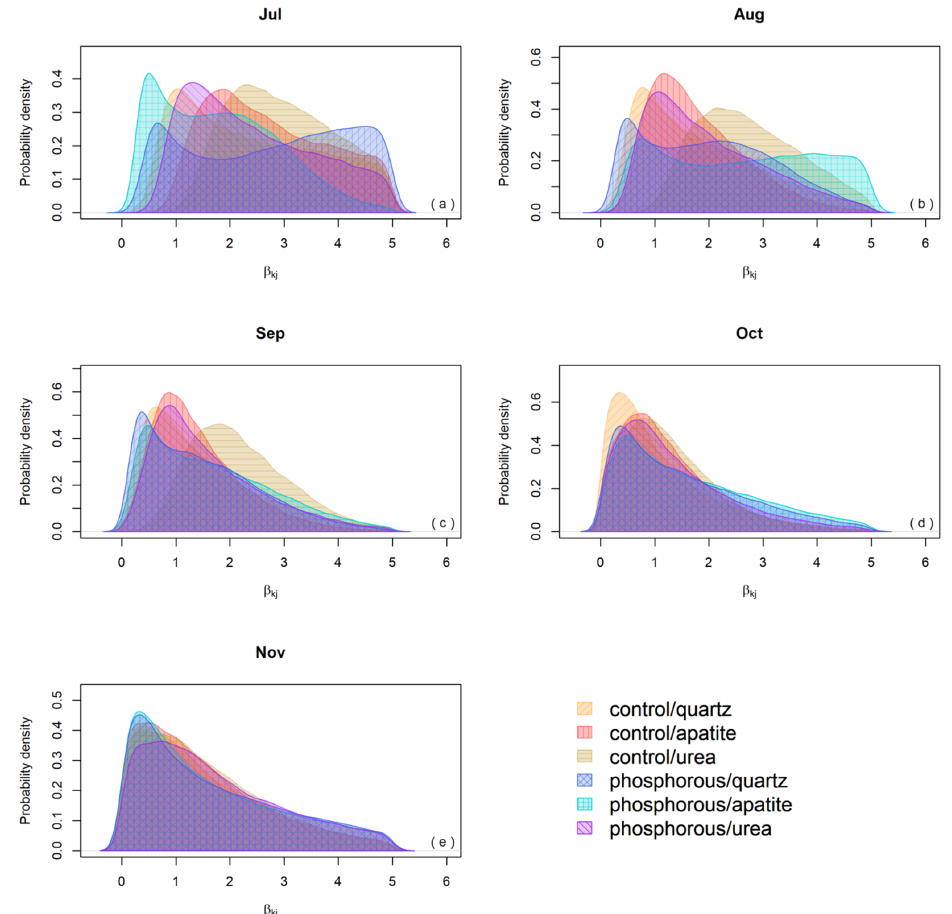
Figure 5. Seasonality effect on biomass production expressed by the β parameter for the different months of the growing season.